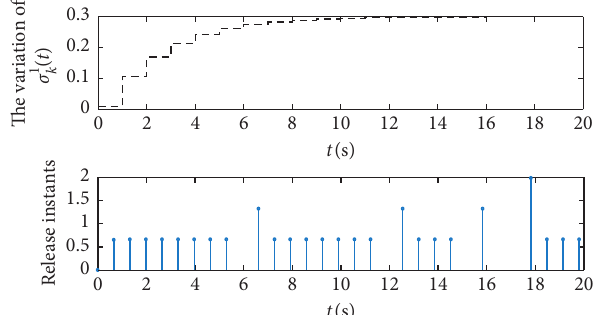
Figure 3: The parameter σ 1